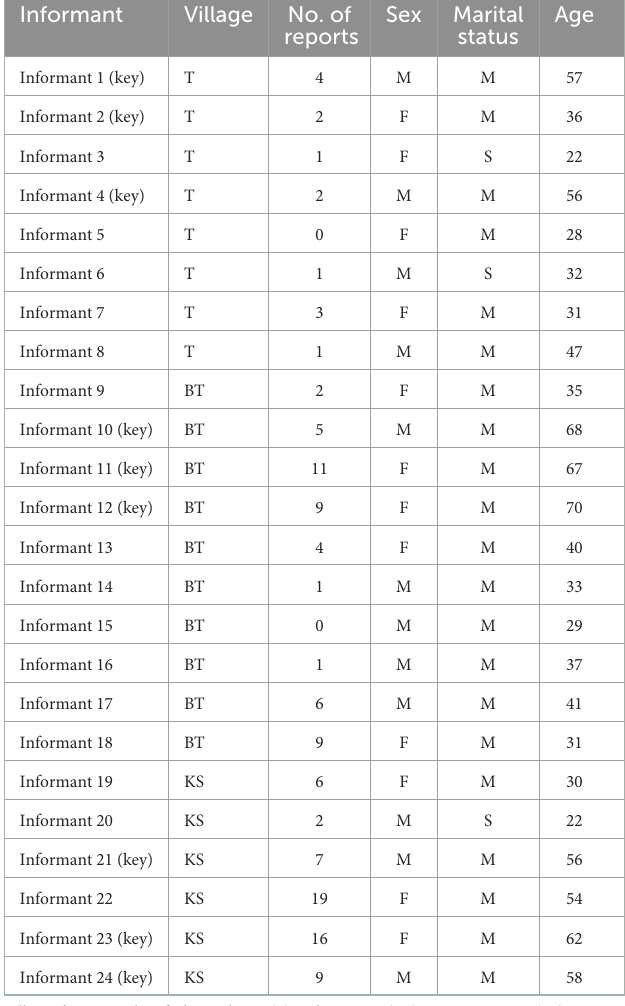
TABLE 1 Participant information.